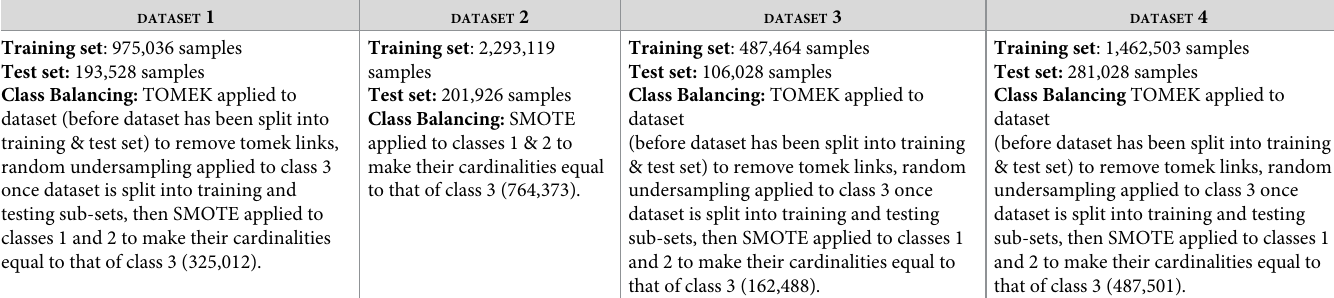
Table 2. Descriptions of the four balancing procedures. The training/test split was done on the number of data samples. DATASET